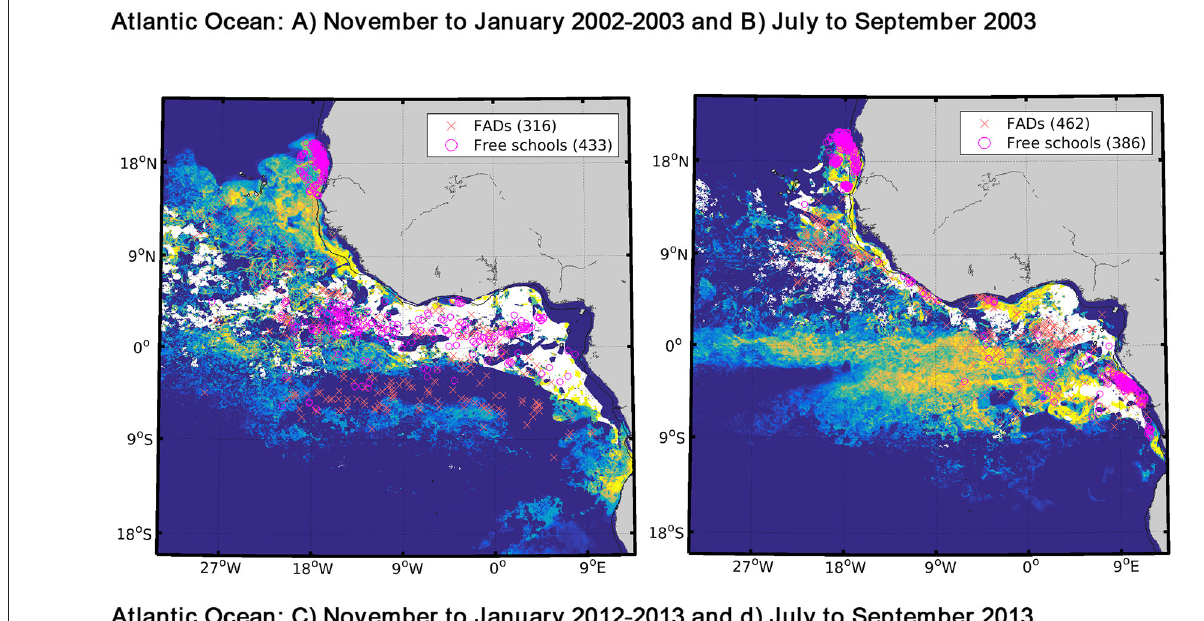
( Figure 6A ). The fraction of total catches (in weight) made up by EU fleet dFAD sets in this area increased from 50 to 75% prior to 2005 to 88–93% after 2006.